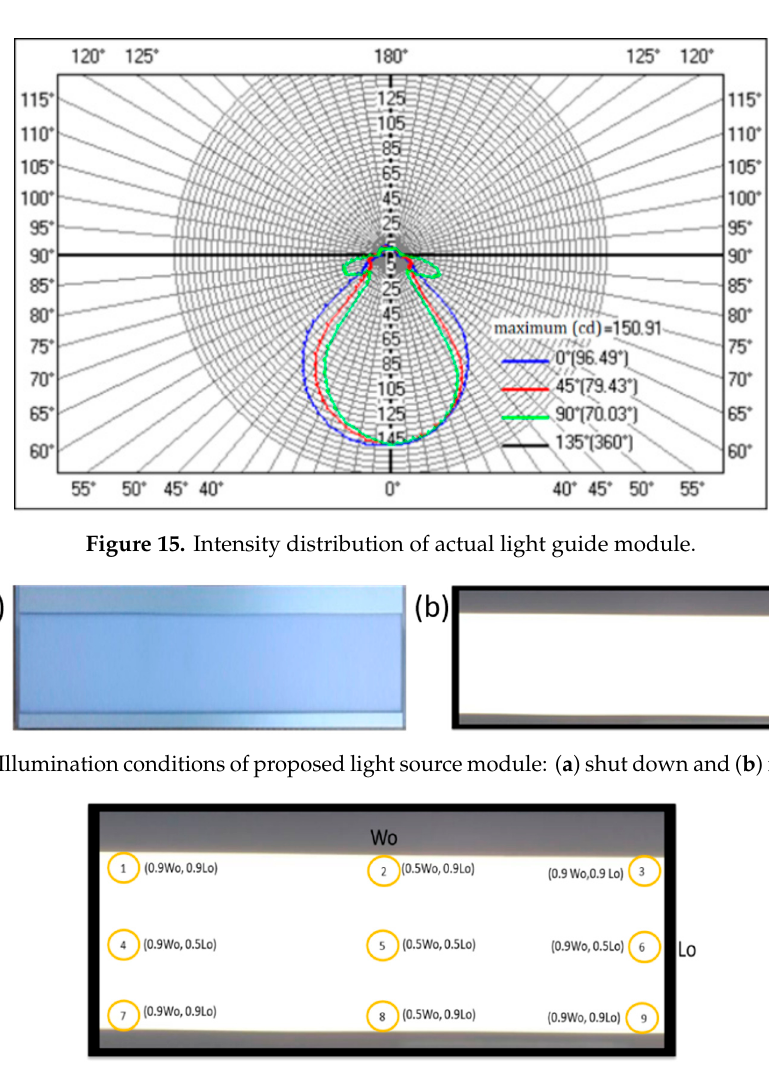
Figure 17. Measurement points on light source module for uniformity evaluation. Table 6. Relative luminance measured at nine points.